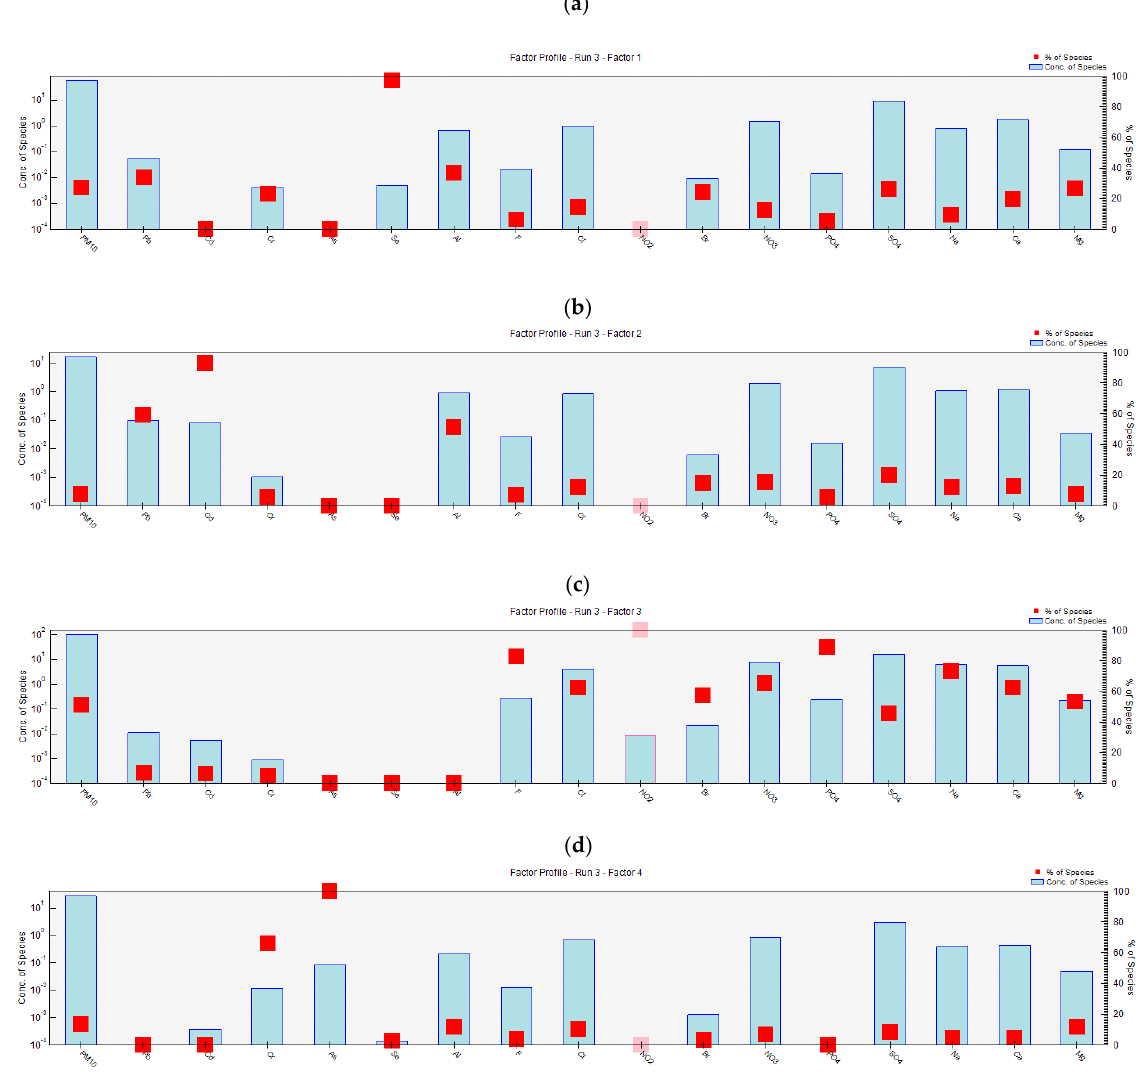
Figure 7. Results of the positive matrix factorization (PMF) run 3 (the convergent run), showing profiles % of species for factor 1 ( a ), factor 2 ( b ), factor 3 ( c ) and factor 4 ( d ). Table 2. Results of the positive matrix factorization run 3 (the convergent run), showing profile % of species, % of factor total and concentrations of species in each factor (factor 1 to factor 4).